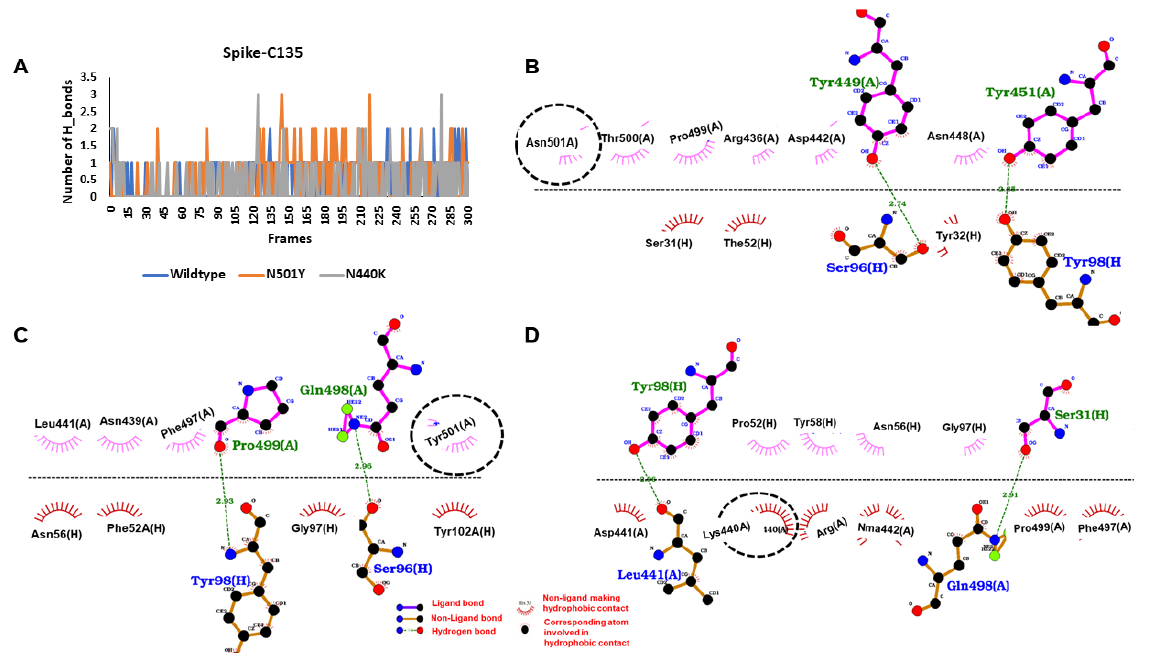
Figure 3. Binding interactions and energy of spike proteins with C135 antibody. ( A ) The hydrogen bond peaks showing the interaction of mutants were better than wildtype spike protein. ( B ) The binding interaction of wildtype spike protein with heavy chain of C135 antibody, N501 (circled) making hydrophobic contact (hydrogen bonds are shown with green dots and non-polar interactions with magenta and brick semicircle). ( C ) The binding interaction of N501Y mutant spike protein with heavy chain of C135 antibody. ( D ) The binding interaction of N440K mutant spike protein with heavy chain of C135 antibody.